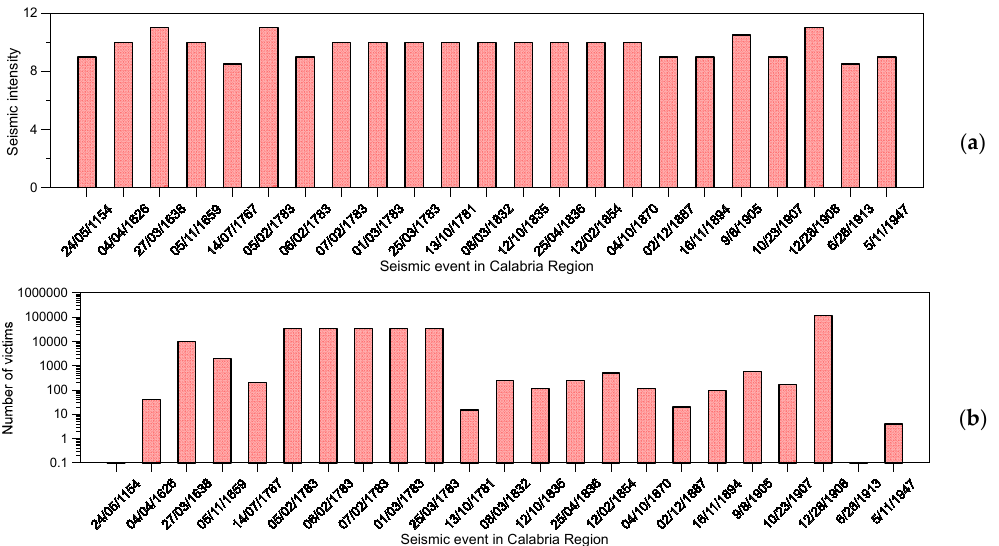
Figure 2. Summary of ( a ) seismic intensity and ( b ) the number of victims of past earthquakes in the Calabria Region.